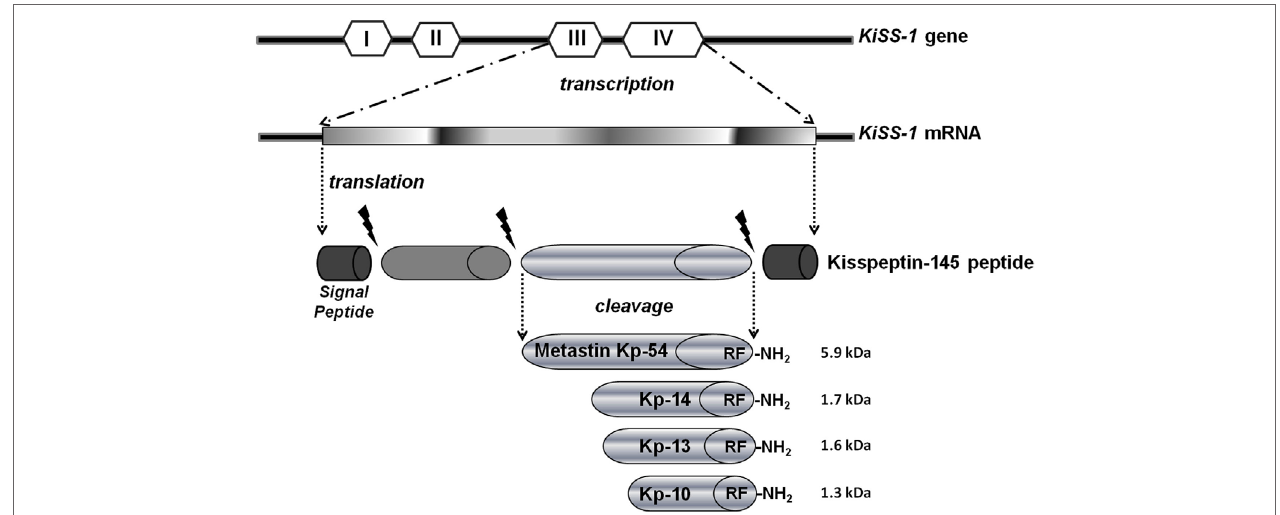
FiGURe 1 | Kisspeptins (Kps)